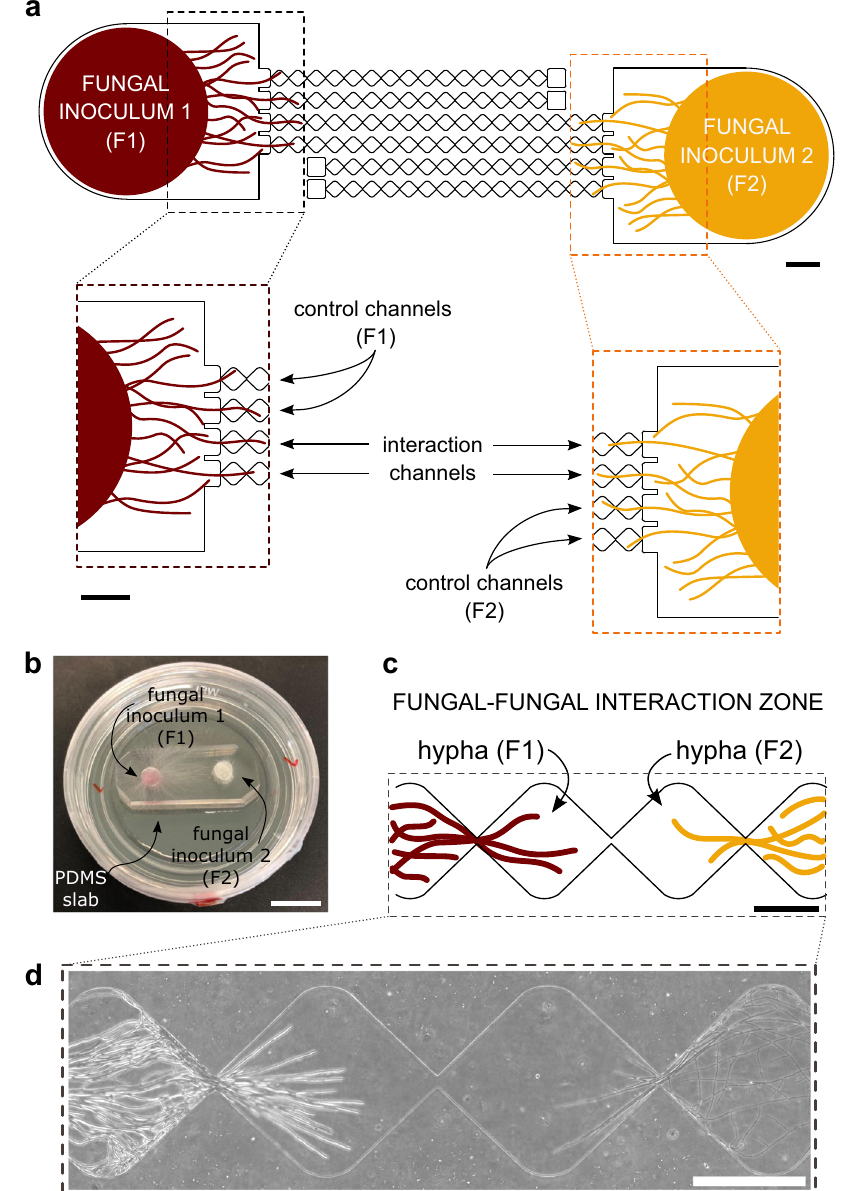
Fig. 1 Design of the micro fl uidic fungal – fungal interaction (FFI) device. a Overview of the FFI device, showing the nature of the interaction and control channels and how they are connected to the fungal inocula. The enlarged regions of interest (dashed boxes) illustrate the directed growth of the fungal inoculum towards the control and interaction channels (duplicates of each channel type). Scale bar = 1 mm. b Photograph illustrating the FFI device. Two fungal inocula plugs of equal size (F1 and F2) can be introduced into the device, allowing hyphal growth and therefore confrontation of two fungal strains via interconnected microchannels. Microchannels feature on the surface of a poly(dimethylsiloxane) (PDMS) slab bonded to a glass-bottomed Petri dish. Scale bar = 1 cm. c Schematic representation of the interaction zone between the two fungi, consisting of equally sized, diamond-shaped segments that trigger a funnel effect and therefore regulate hyphal advance along the microchannel. Scale bar = 250 µ m. d Phase contrast image taken from the interaction zone showing hyphae from two different fungal strains growing towards one another. Scale bar = 250 µ